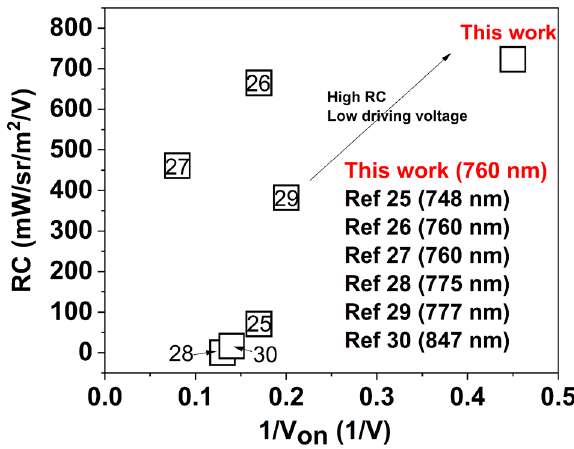
Figure 6. Radiance capacity depending on V on (Plotted by referring to NIR OLEDs based on Ir(III)